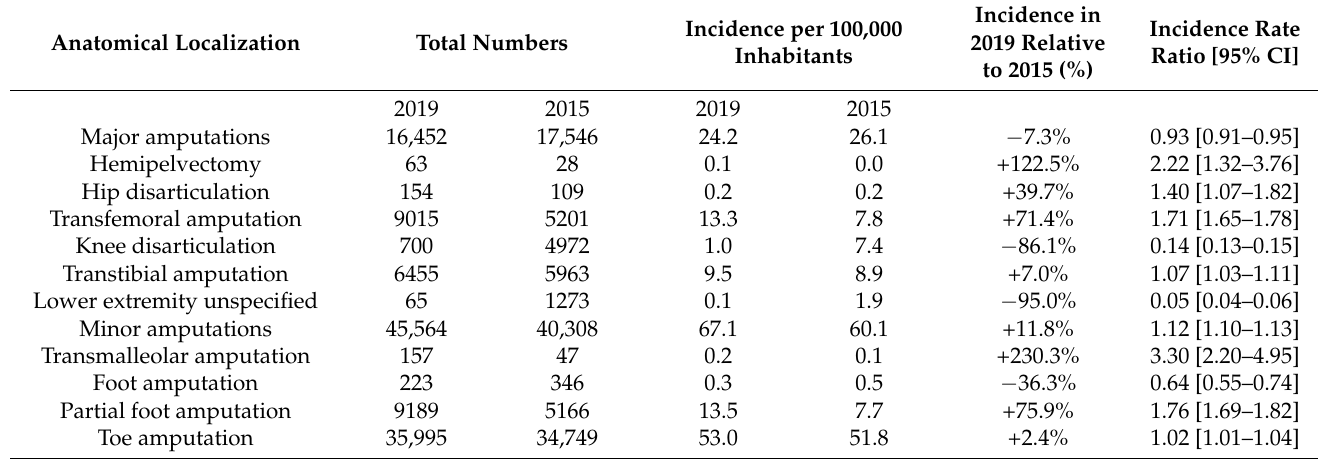
Table 2. Incidence rates of the distinct amputation procedures performed in the year 2019 compared to 2015.